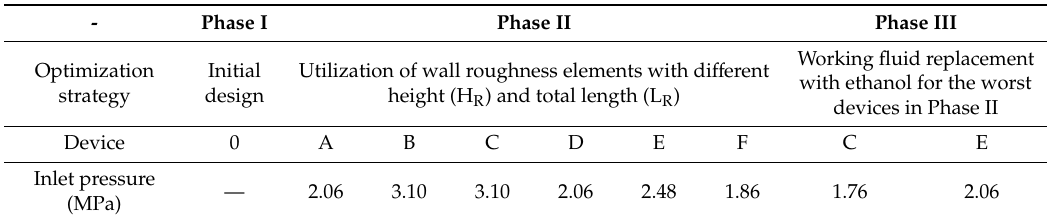
Table 2. The three design and optimization phases in this